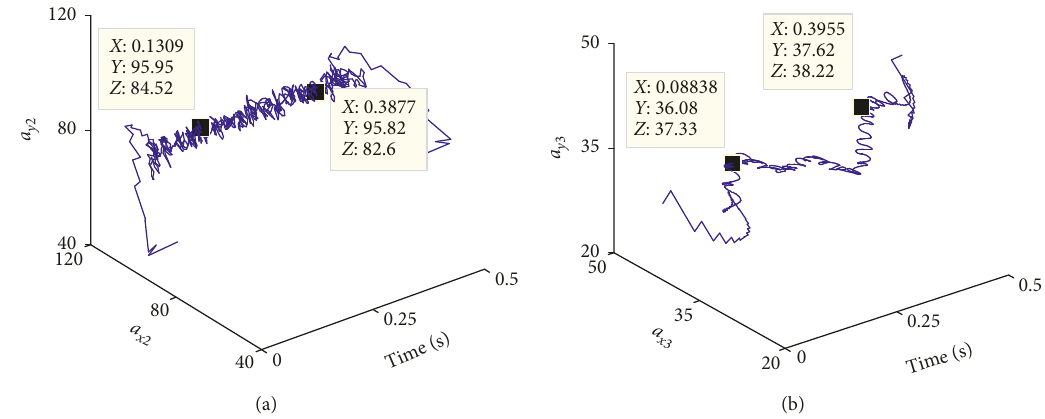
Figure 18: The 3D time domain of the instantaneous amplitude of a